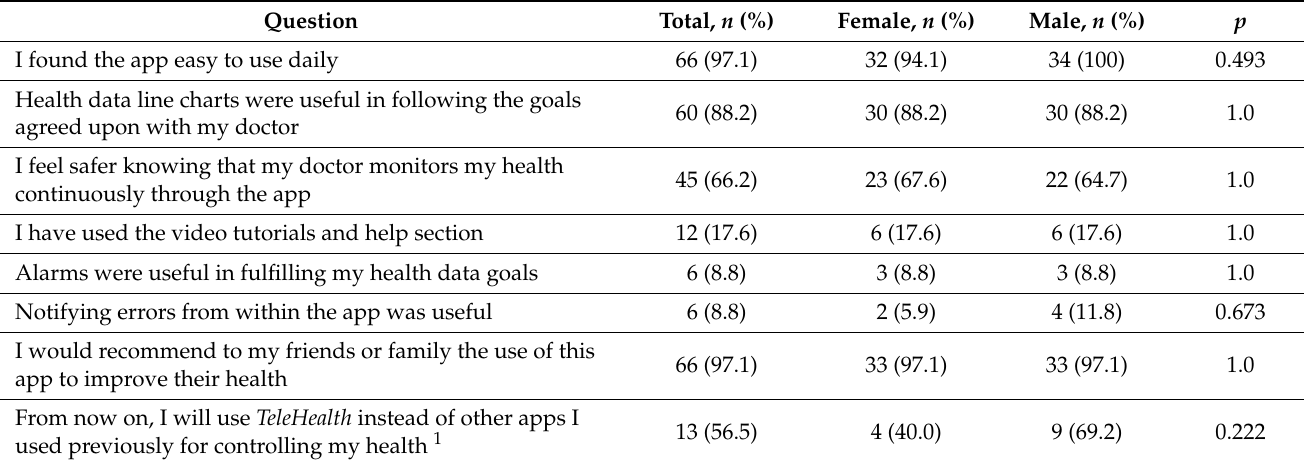
Table 6. Satisfaction of participants after using the TeleHealth